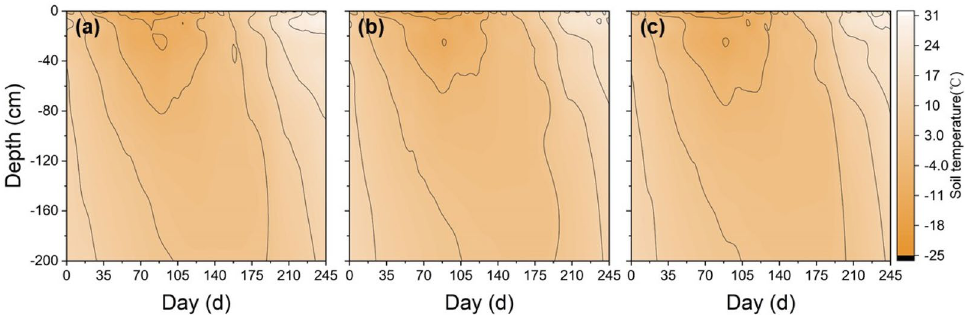
Figure 2. Contour map of soil temperature in farmland ( a ), LT grassland ( b ) and AS land ( c ) from 24 October, 2015 to 25 June, 2016.